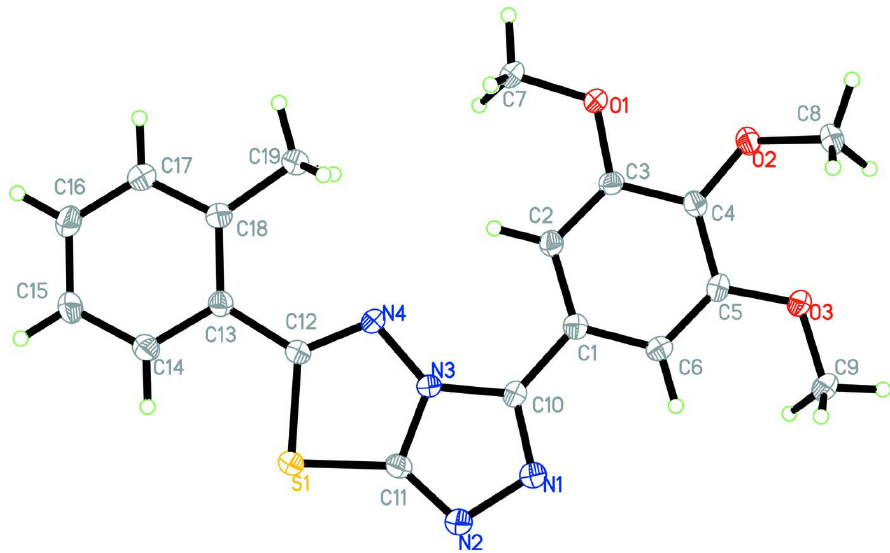
The molecular structure of the title molecule, with the atom-numbering scheme. Displacement ellipsoids are drawn at the 50% probability